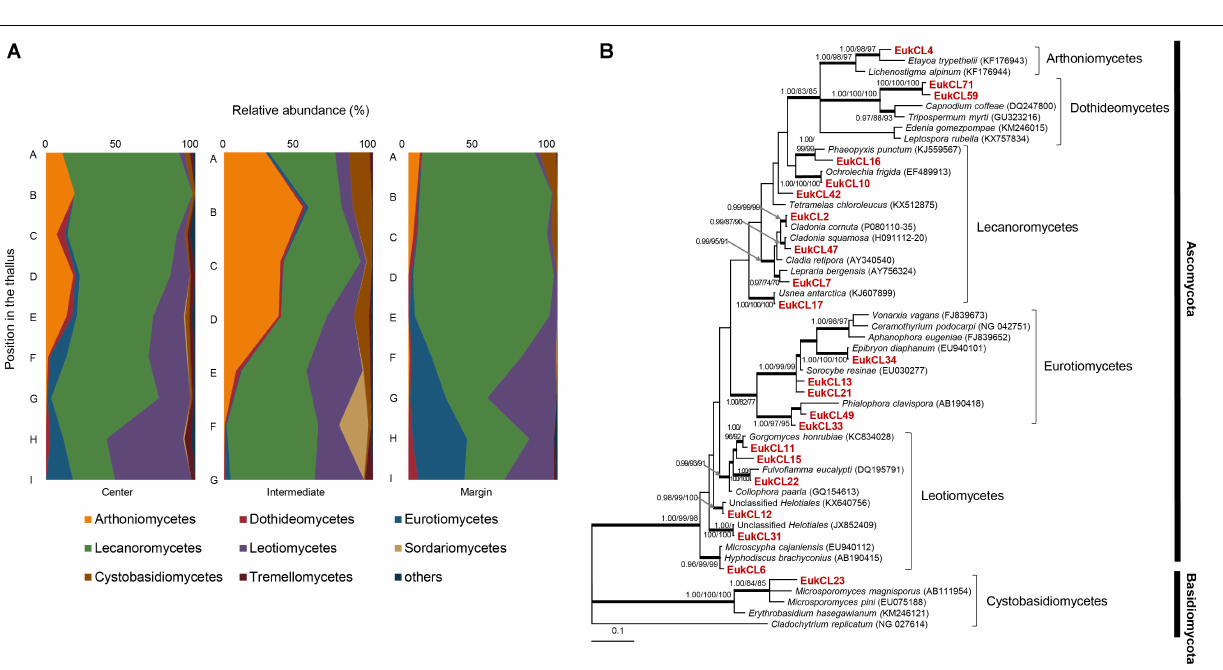
FIGURE 4 | Lichen-associated fungal composition and phylogenetic tree of major fungal OTUs. (A) Composition of lichen-associated fungi at the class level along the vertical position of thalli. Positions of thalli in the colony and labels of subsection were illustrated in Figure 1B . (B) Bayesian tree of major OTUs ( > 0.5% relative abundance). Thick branches represent those that were conserved in Bayesian, ML, and MP analyses. Posterior probabilities and bootstrap values ( > 0.9 and > 70%) were shown on corresponding branches (Bayesian/ML/MP). The tree was rooted with Cladochytrium replicatum (NG 027614, Chytridiomycota). Detailed information for relative abundance of classes and OTUs was included in Supplementary Tables S3,S4